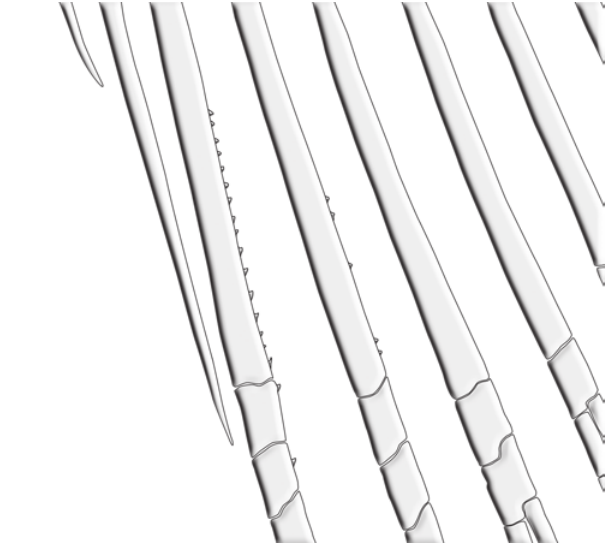
Fig. 20. Hooks on anterior anal-fin rays of Charax niger , MZUSP 33424, male, 105 mm SL.